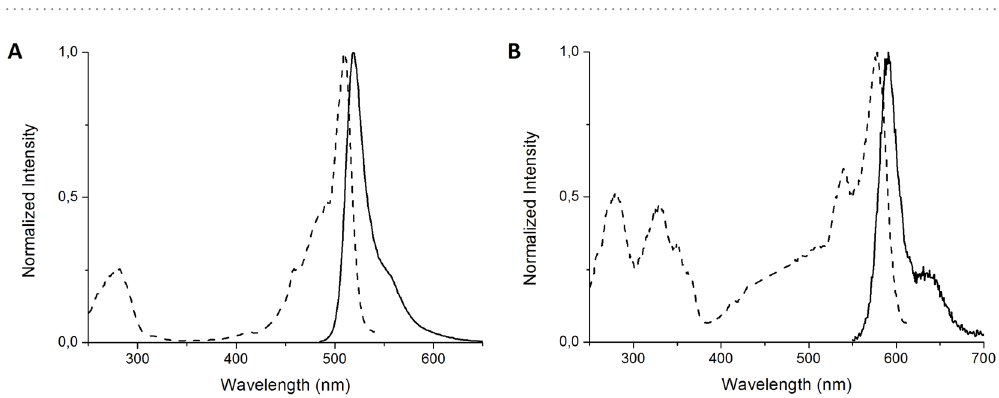
Figure 6. Normalized excitation and emission spectra of the K145E mutant before photoconversion ( A , green state) and after complete photoconversion ( B , red